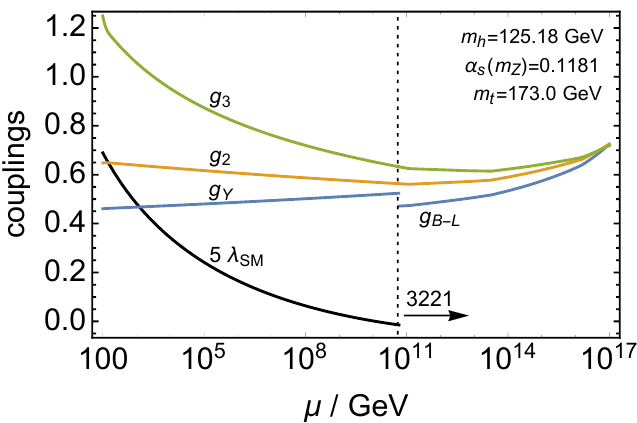
Figure 1 . Precise gauge coupling uni(cid:12)cation via Higgs Parity. The intermediate scale is the energy scale where the running Higgs quartic coupling of the Standard Model nearly